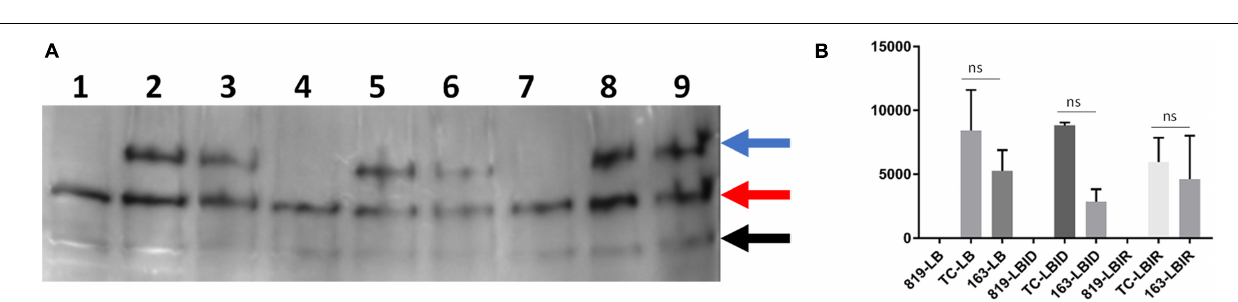
FIGURE 5 | Western blot analyses of IutA encoded by IncFIB plasmid. (A) Protein expression was detected by chemiluminescence. Lanes 1, 4, 7: protein lysate prepared from the recipient strain-SE819; Lanes 2, 5, 8: from transconjugant (SE819:IncFIB); Lanes 3, 6, 9: from wild type-SE163. Lanes 1–3: All three strains grown in LB; lanes 4–6: were grown in LBID; Lanes 7–9: grown in LBIR. Three proteins were detected by western blot analyses as indicated by the blue arrow, a protein of ∼ 70 KDa; red arrow a protein of ∼ 50 KDa, and black arrow a protein of ∼ 30 KDa. This is a magnified area of an original blot that is shown in Supplementary Figure 3 . (B) Band 1 ( ∼ 70 KDa) was quantified from three independent blots by ImageJ. Student’s t -test was performed between TC-LB vs. 163-LB; TC-LBID vs. 163-LBID; TC-LBIR vs. 163-LBIR with data being considered significant when p < 0.05. Although expression of IutA was decreased in SE163 as compared with transconjugant in all three conditions (LB, LBID, and LBIR), however; this difference was statistically